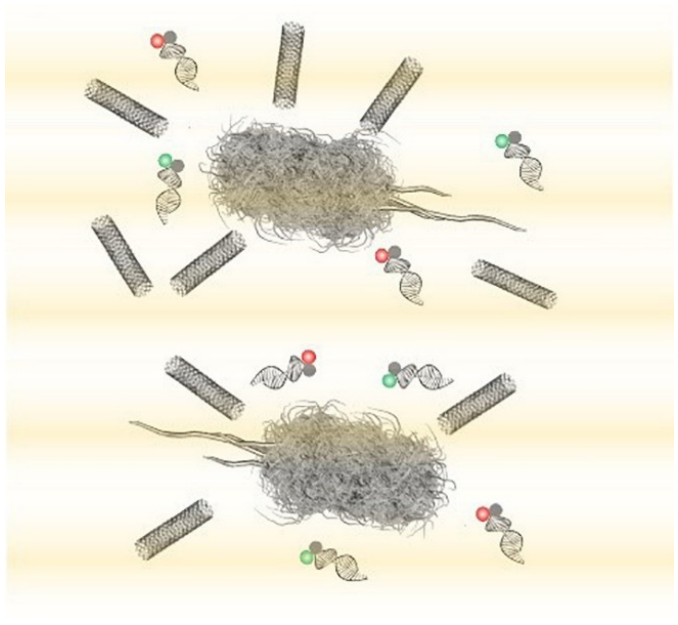
Figure 6. Nanotube assisted microwave electroporation (NAME) for single-cell pathogen identification. Multiwall carbon nanotubes induce localized electroporation for the delivery of multicolour double-stranded molecular probes for multiplex 16S rRNA detection [71].